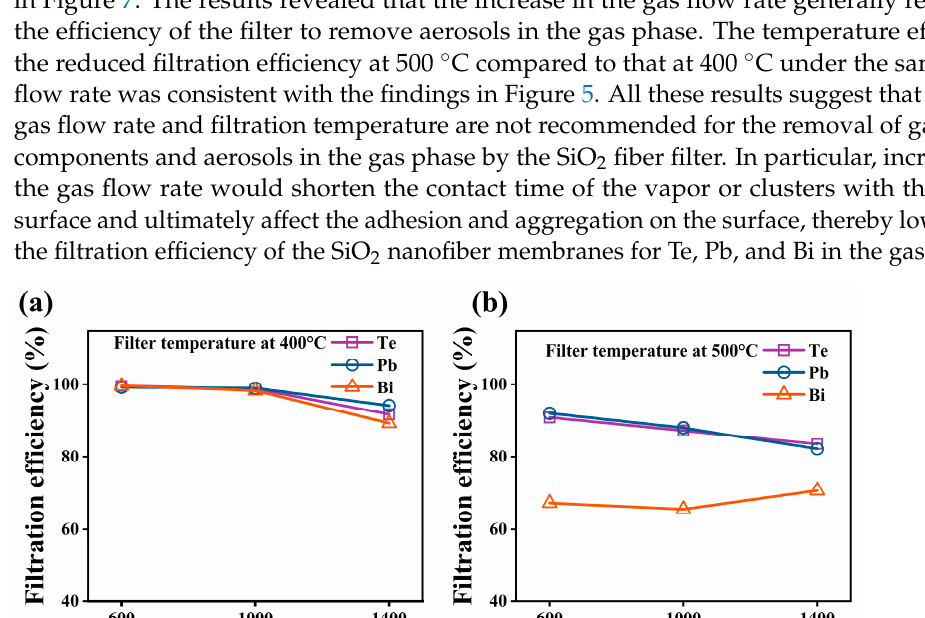
Figure 8. Filtration efficiency in five cycles. 3.3. DFT Calculation The adhesion behaviors of the volatile components PbTe and Bi from the LBE-Te sample with amorphous SiO 2 were considered. For comparison, the adhesion properties of Te and Po-containing molecules (Po, PbPo)) were also evaluated. Figure 9 shows the adhesion configuration of monoatomic molecules (Po, Te, Bi) and diatomic molecules (PbTe, PbPo) at the defect sites on the amorphous SiO 2 surface. Table 2 lists the calculated adhesion energies of the different configurations on the amorphous SiO 2 surface defect sites. The results showed that the adhesion energies of all the configurations were nega- tive, indicating that the molecules could be spontaneously adsorbed on the SiO 2 surface. The adhesion energies for monoatomic molecules (Te, Bi, and Po) on the SiO 2 surface were